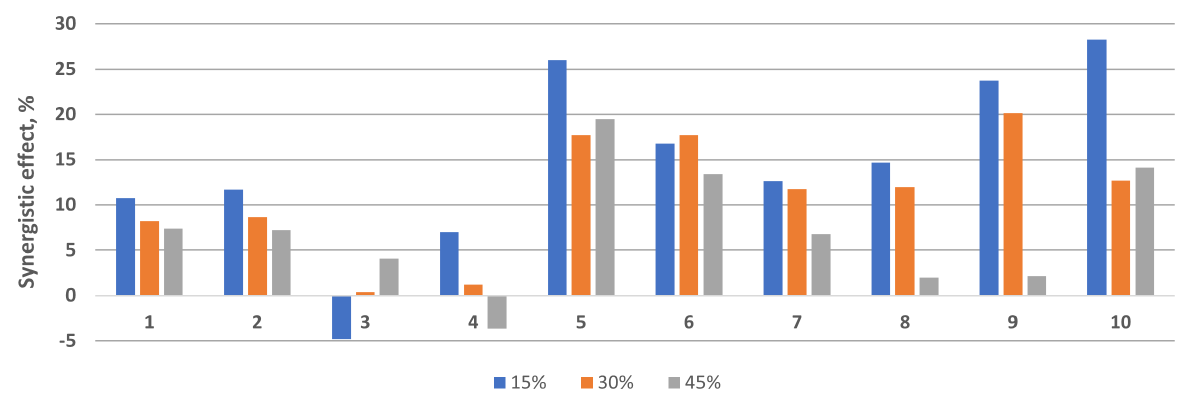
Figure 4. Estimated synergistic effect on average weight loss rate of MW pre-treated (shown in legend percentage, %) and raw pellets for all blends: 1. straw* + straw; T mw = 473 K; 2. straw* + straw; T mw = 548 K; 3. straw* + wood; T mw = 473 K; 4. straw* + wood; T mw = 548 K; 5. straw* + peat; T mw = 473 K; 6. straw* + peat; T mw = 548 K; 7. wood* + straw; T mw = 473 K; 8. wood* + straw; T mw = 548 K; 9. wood* + peat; T mw = 473 K; 10. wood* + peat; T mw = 548